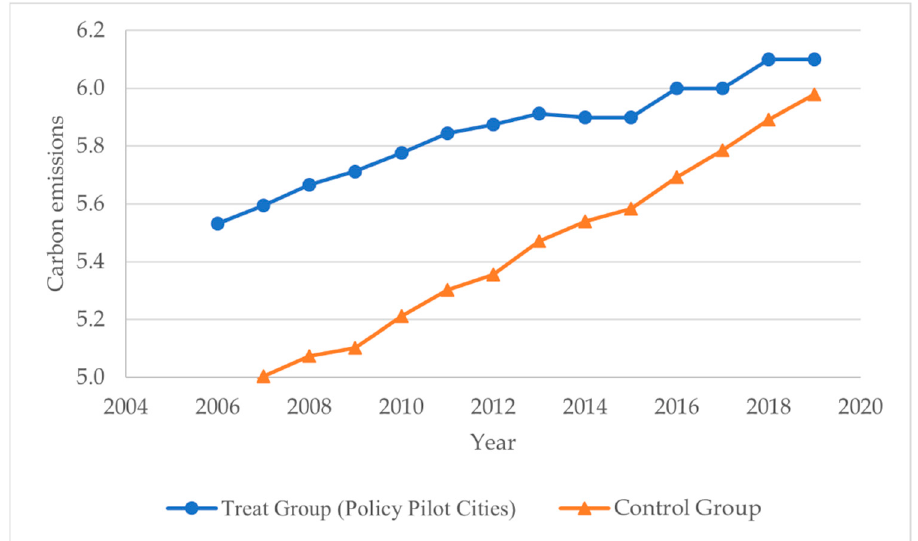
Figure 2. 2007–2019 carbon emission trend chart of Treatment Group and Control Group cities.